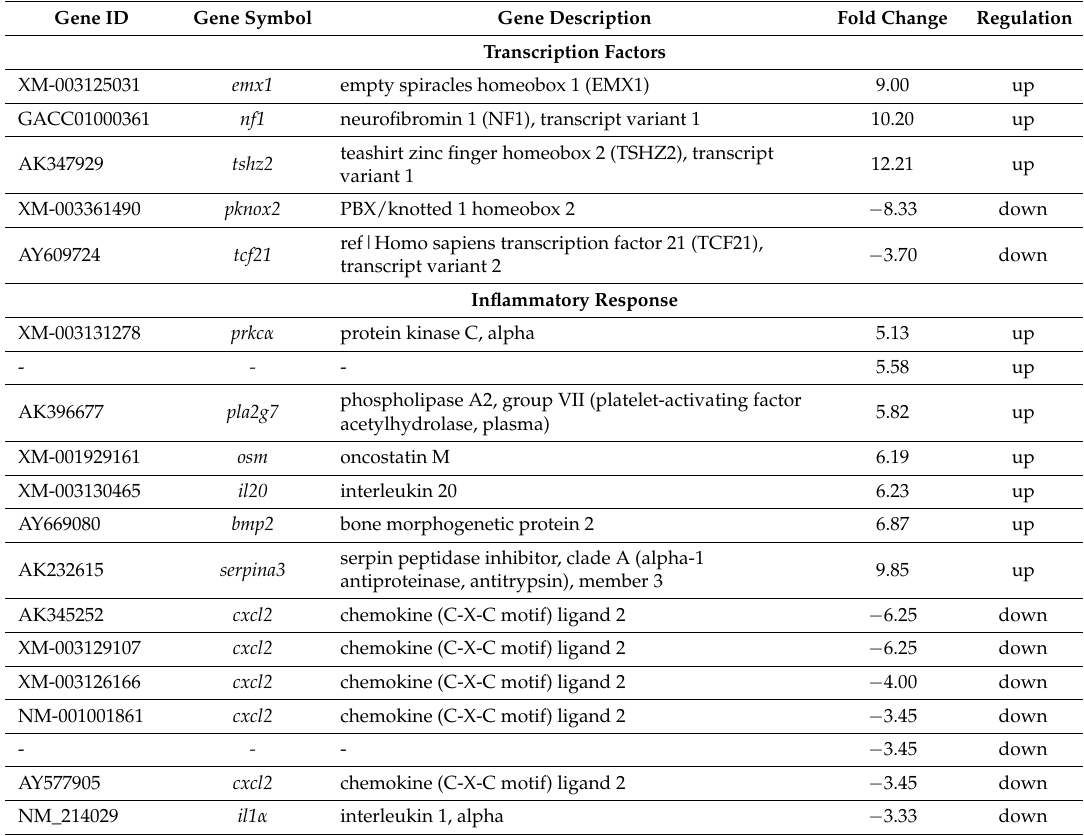
Table 4. List of the most strongly upregulated or downregulated genes associated with transcription factors and inflammatory response in IPEC-cells.